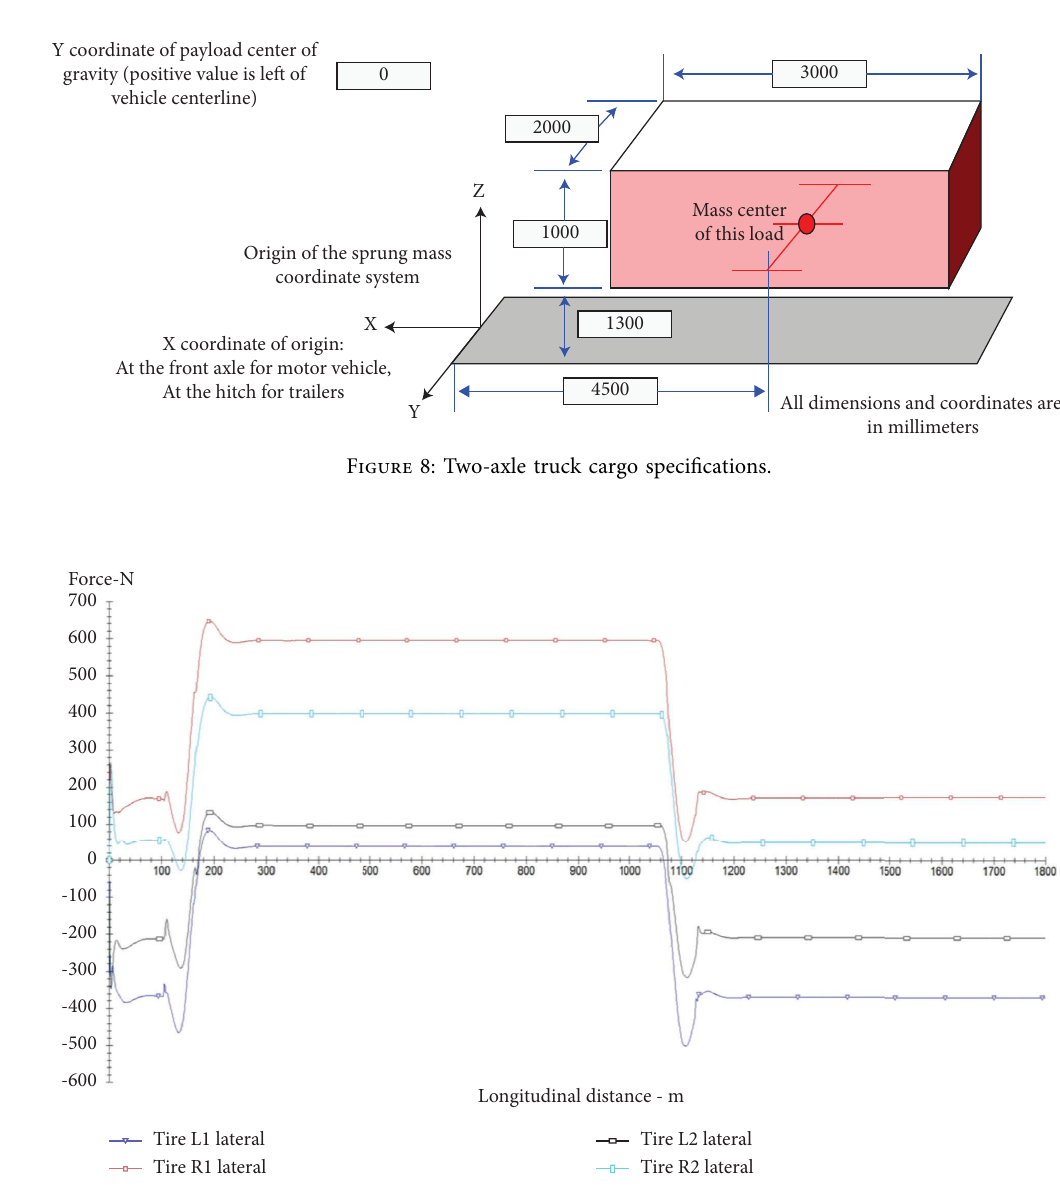
Figure 9: Diagram of the lateral force on the wheels of vehicles.